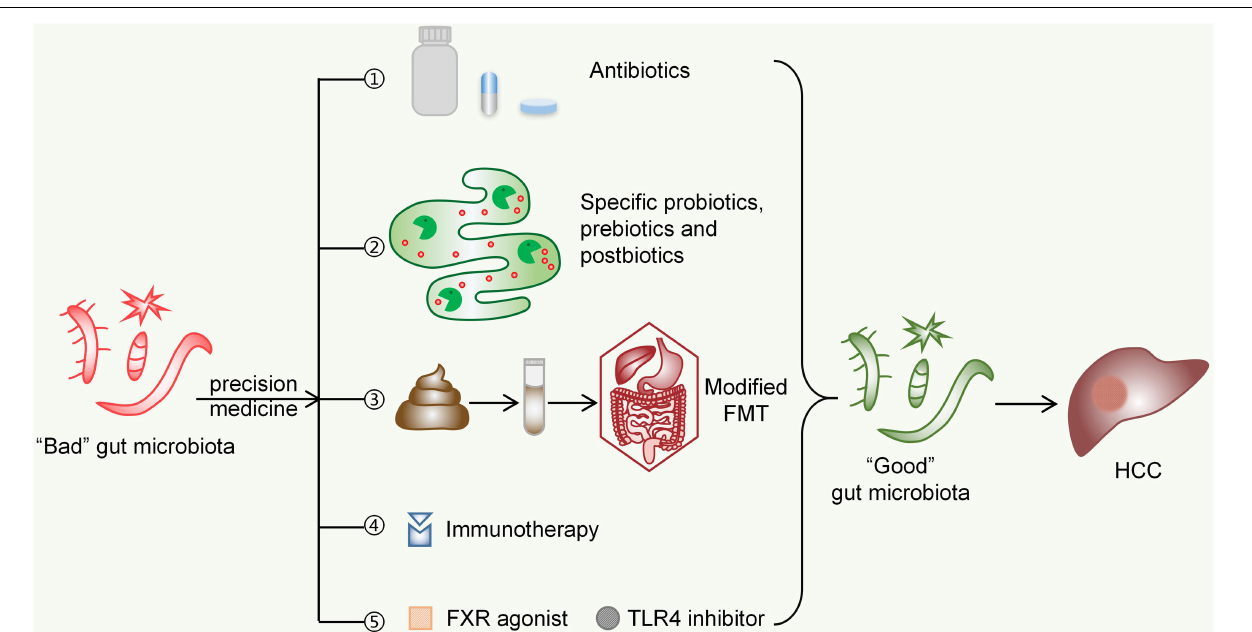
FIGURE 4 | Possible future strategies for targeting the gut microbiota in the treatment of HCC. (cid:192) Antibiotics such as rifaximin, norfloxacin, and others are capable of scavenging specific gut microbes to inhibit HCC progression. (cid:193) Specific probiotics, prebiotics, and postbiotics may inhibit the development of HCC by maintaining the gut microecological environment and improving gut barrier functions. (cid:194) Modified FMT (adjustment of components, delivery frequency, delivery route, etc.) can bring the gut microbiota of HCC patients closer to those of normal people. (cid:195) The immunosuppressive environment shaped by harmful species of the gut microbiota can be improved by immunotherapy targeting CTLA-4 and PD-1. (cid:196) FXR agonists (such as obeticholic acid) and TLR4 inhibitors (such as eritoran) can affect bile acid metabolism and immune response signalling, respectively, both of which might inhibit HCC development by indirectly altering the gut microbiota. FMT, faecal microbiota transplantation; FXR, Farnesoid X receptor; TLR4, Toll-like receptor 4; HCC, hepatocellular